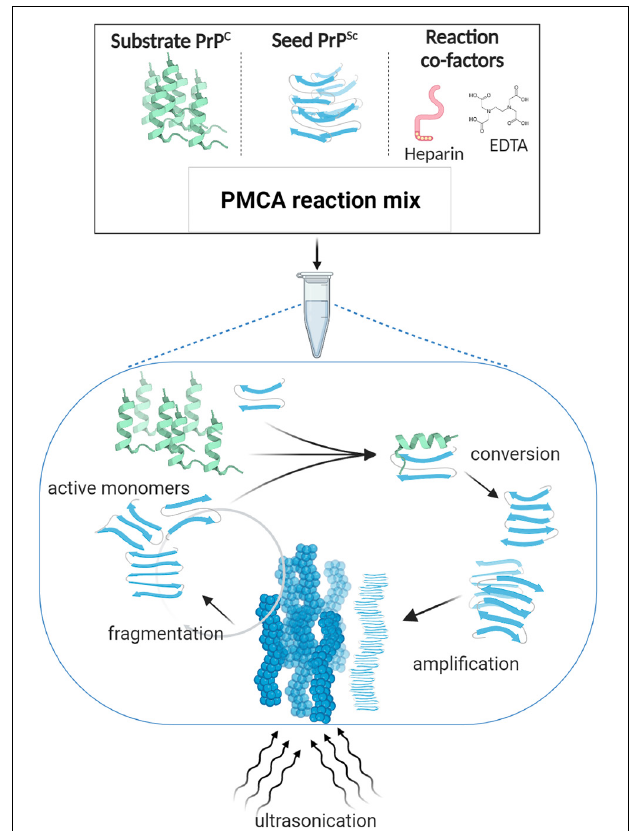
FIGURE 1 | Protein misfolding cyclic amplification (PMCA). PMCA reaction mix is composed of minute amounts of the misfolded abnormal β sheet-rich prion protein (seed PrP Sc ) and a large excess of the normal α -helix prion protein (substrate PrP C ), in addition to reaction cofactors such as ethylenediaminetetraacetic acid (EDTA) and heparin as reported for some of the established protocols (Barria et al., 2014b, 2018a; Ritchie et al., 2017). The PMCA reaction mimics the in vivo PrP conversion; i.e., according to the template-directed model of propagation, when incubated at 37 ◦ C, PrP Sc interacts with PrP C and thereby alters its conformation. The newly formed misfolded subunits grow and aggregate to form large fibrillary structures. Ultrasonication is applied to break down the misfolded aggregates into active converting “seeds” that lead the reaction again in a cyclic manner. By the end of one 48-h round of PMCA, most PrP C molecules are converted into its misfolded form, enabling their subsequent detection by western blotting.